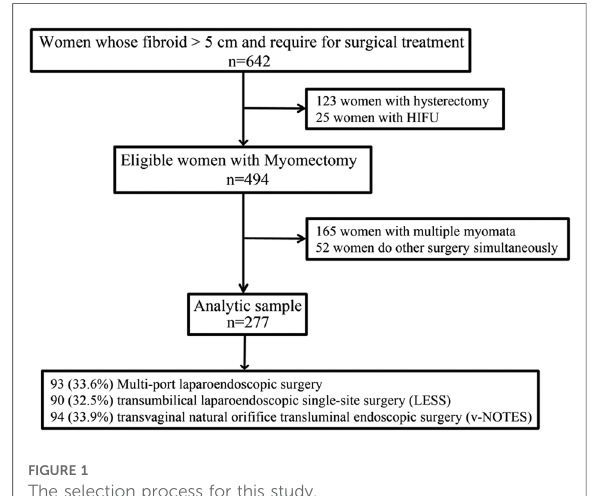
FIGURE 1 The selection process for this